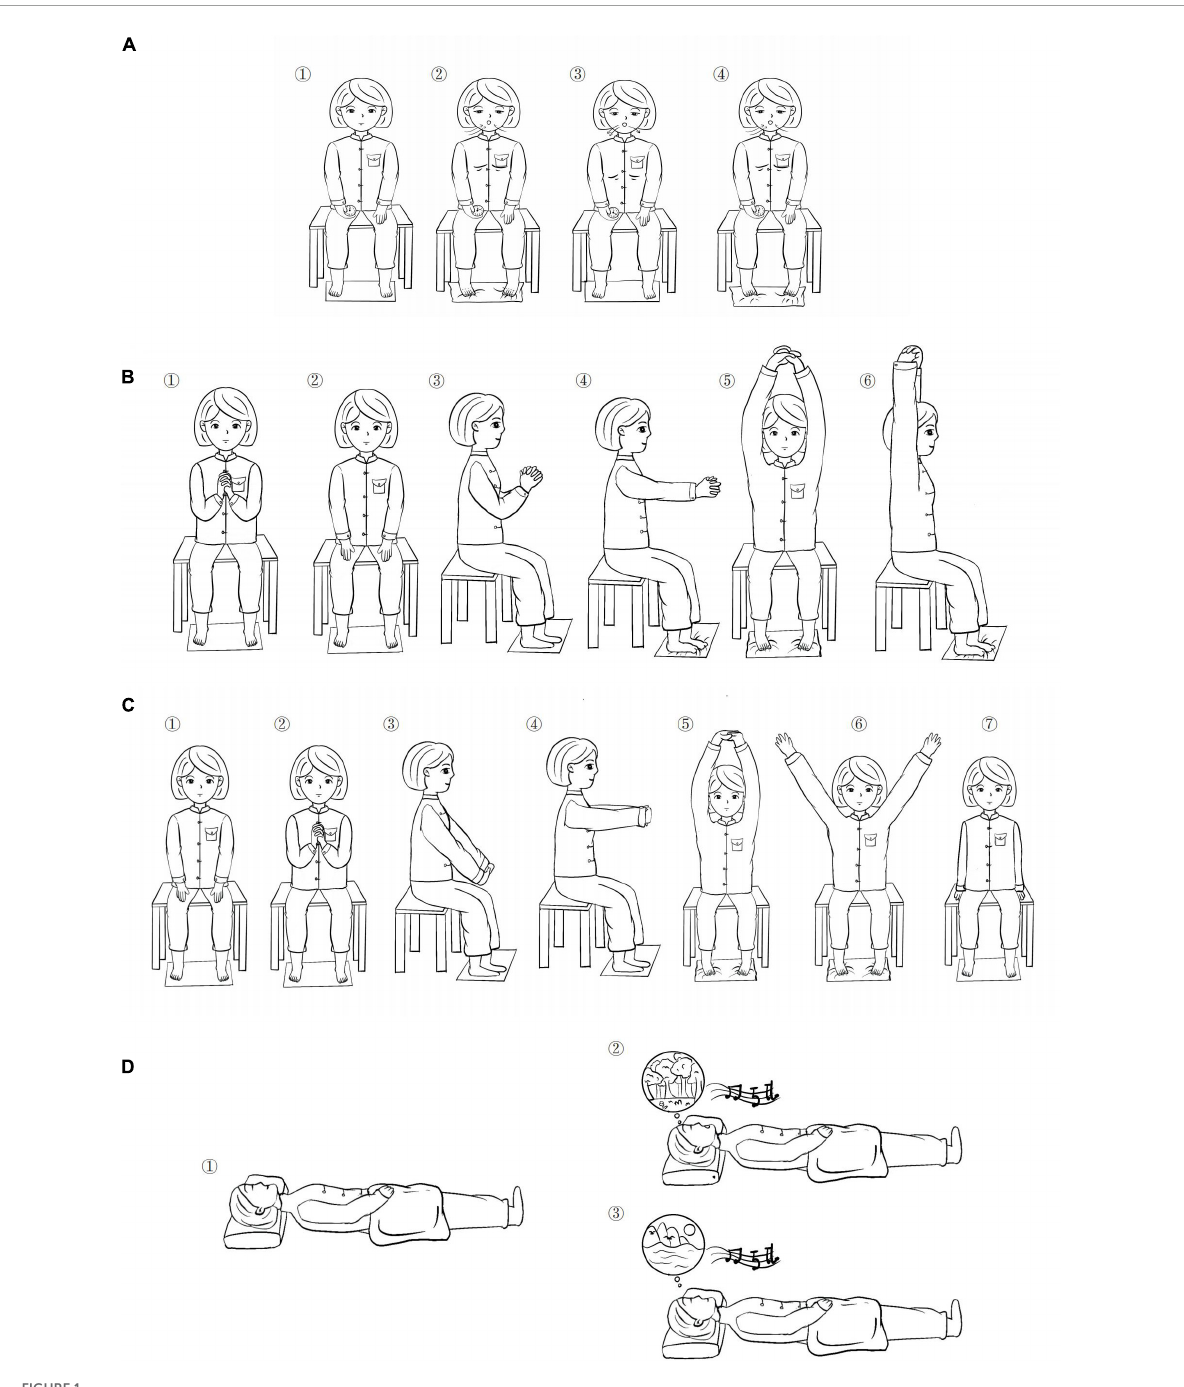
FIGURE1 Qigong operation steps. (A) Action 1 Breathing practice; (B) Action 2 Sitting position Yijinjing (YJJ); (C) Action 3 Sitting position YJJ; and (D) Action 4 meditation and